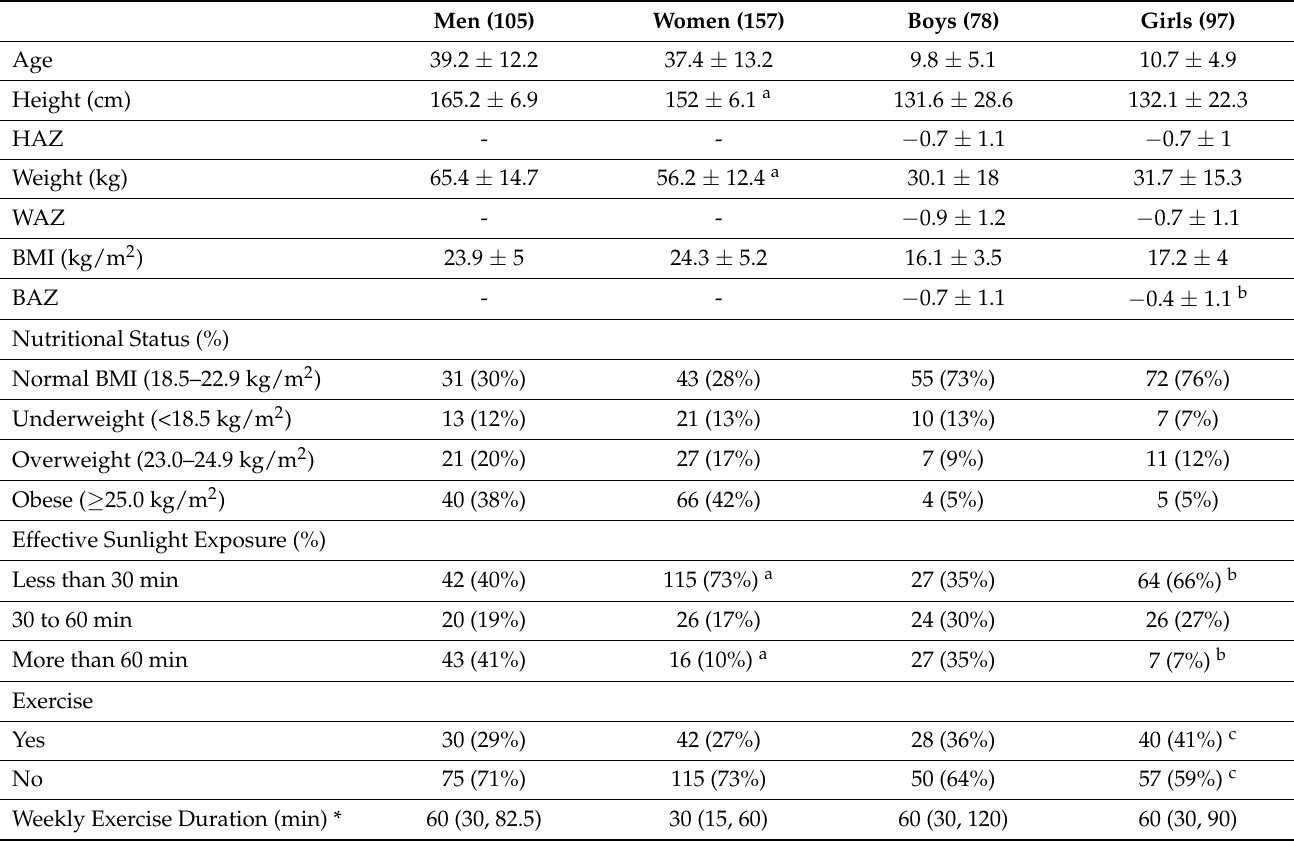
Table 1. Anthropometric characteristics and lifestyle of the participants.